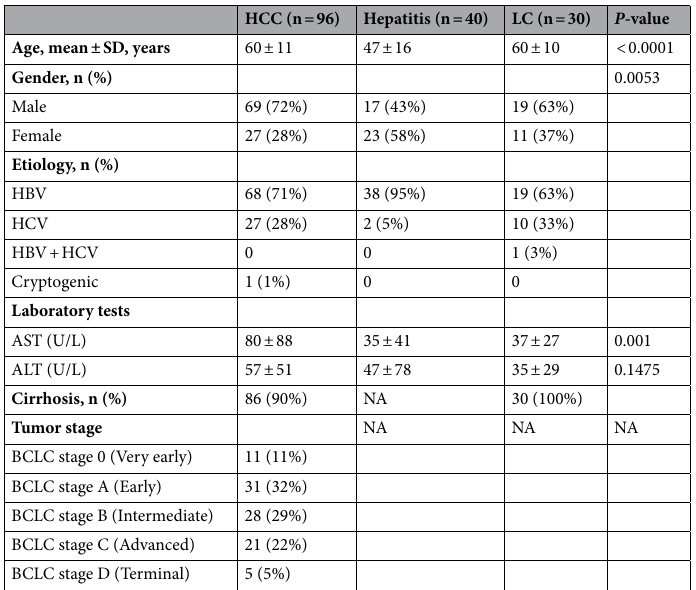
Table 1. Characteristics of study participants. ALT alanine aminotransferase, AST aspartate aminotransferase, BCLC Barcelona Clinic Liver Cancer, HBV hepatitis B virus, HCC hepatocellular carcinoma, HCV hepatitis C virus, LC liver cirrhosis, NA not applicable, SD standard